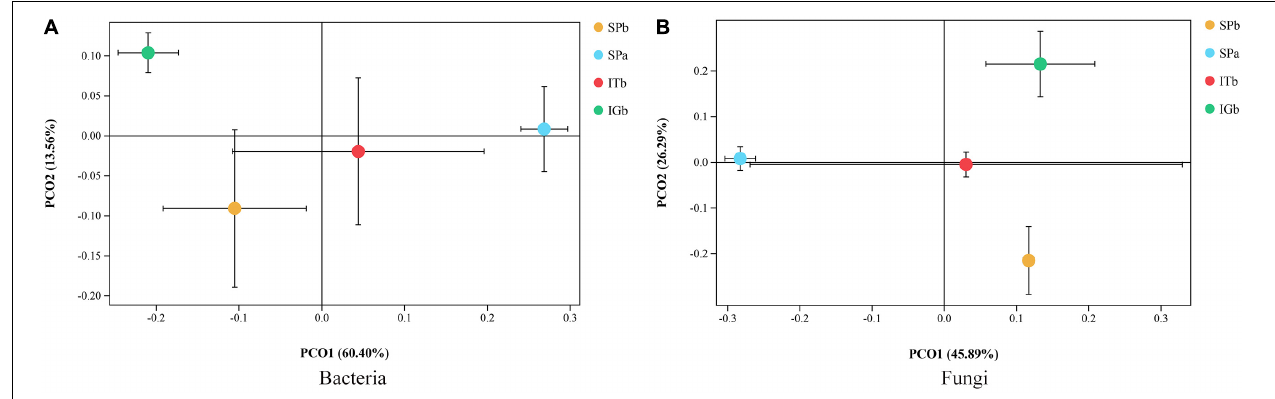
FIGURE 3 | Soil microbial NMDS models for bacteria and fungi when the various planting modes were applied. (A) The differences in the bacterial community structures. (B) The differences in the fungal community structures.